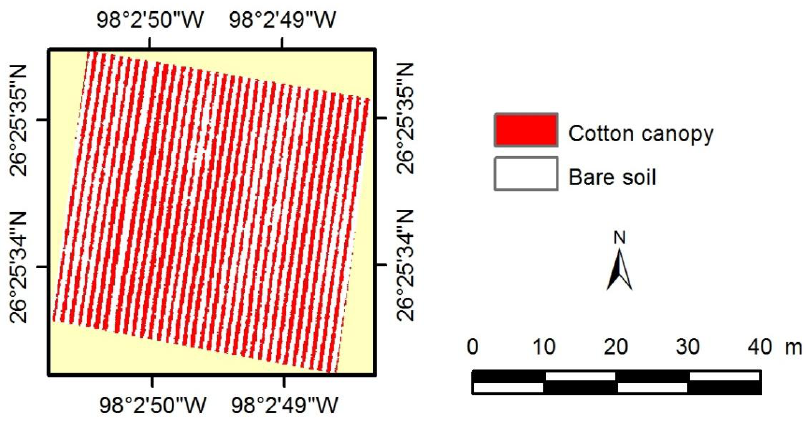
Figure 7. Classification map of a four-band image for a 40 m × 40 m area within a cotton field based on unsupervised classification. Red represents cotton plants, while white depicts soil